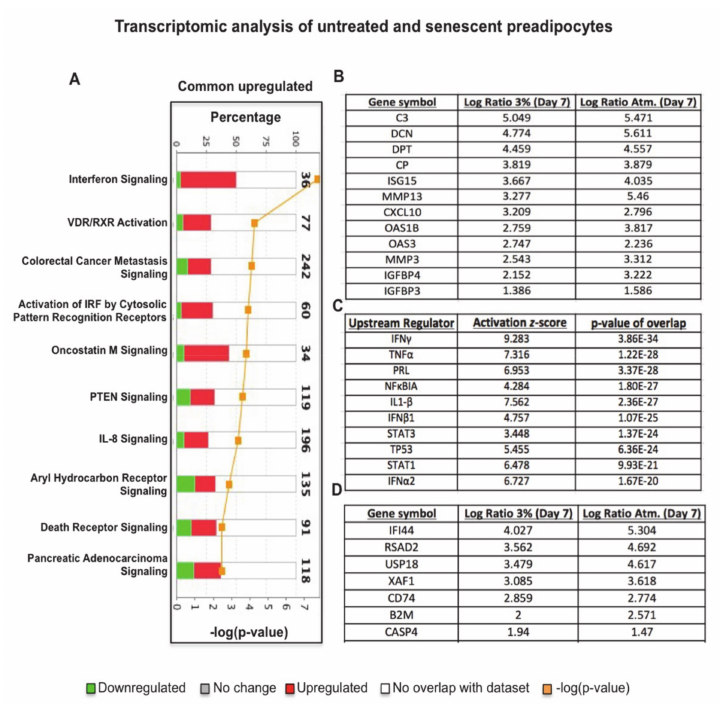
Figure 3. Enriched pathway analysis of up-regulated transcriptome changes in senescent preadipocytes reveal critical activated pro-inflammatory pathways. ( A ) Ten most significantly up-regulated canonical pathways of senescence transcriptome changes by IPA. Axes demonstrate percentages of overlapped genes in each pathway and p -value of overlap. Shaded in red and green is the percentage of up-regulated and down-regulated genes in each pathway. ( B ) Table listing the 12 most significantly up-regulated extracellular annotated genes (putative senescence-associated secretory phenotype (SASP) molecules) in dataset along with their expression values in the indicated condition. ( C ) Table shows IPA predictions of the 10 most significantly activated key regulators in senescent preadipocytes based on assigned IPA p -values of overlap and the degree of activation is based on IPA assigned z-scores of activation; z-score value above +2 signifies activated pathways. ( D ) Table listing the 7 most significantly up-regulated signal transducer and activator of transcription (STAT)1/3 targets along with their expression values in the indicated